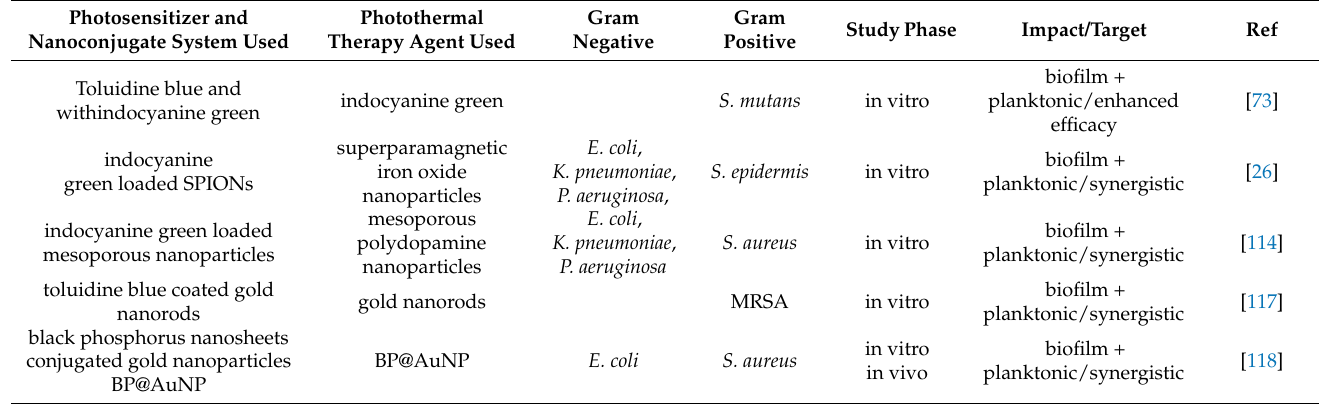
Table 3. Antibacterial photodynamic therapy in combination with photothermal hyperthermia